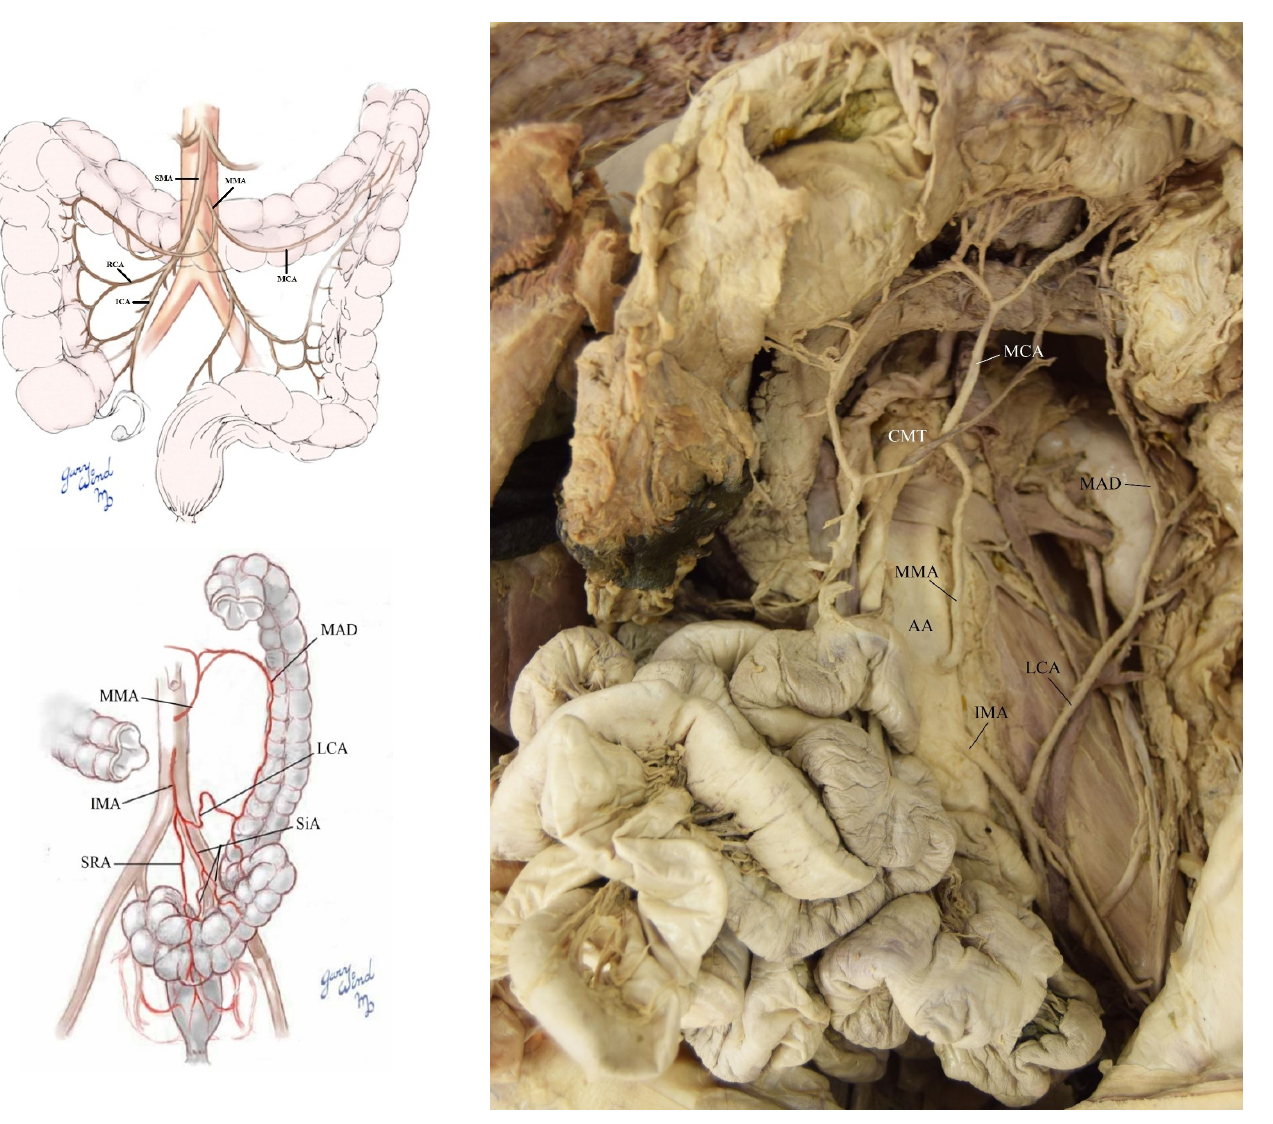
Figure 4. Schematic and gross image of the superior mesenteric artery (SMA), middle mesenteric artery (MMA) and inferior mesenteric artery (IMA) vasculature (clockwise from top left image).